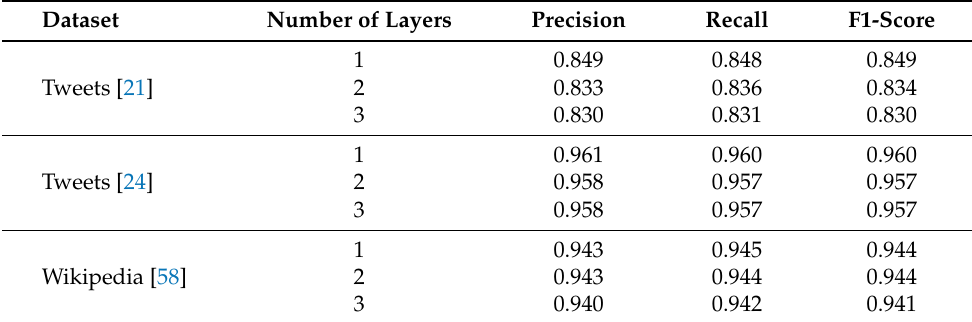
Table 6. Experiment Result for Proposed Method under Various Number of Bi-GRU Layers. Dataset